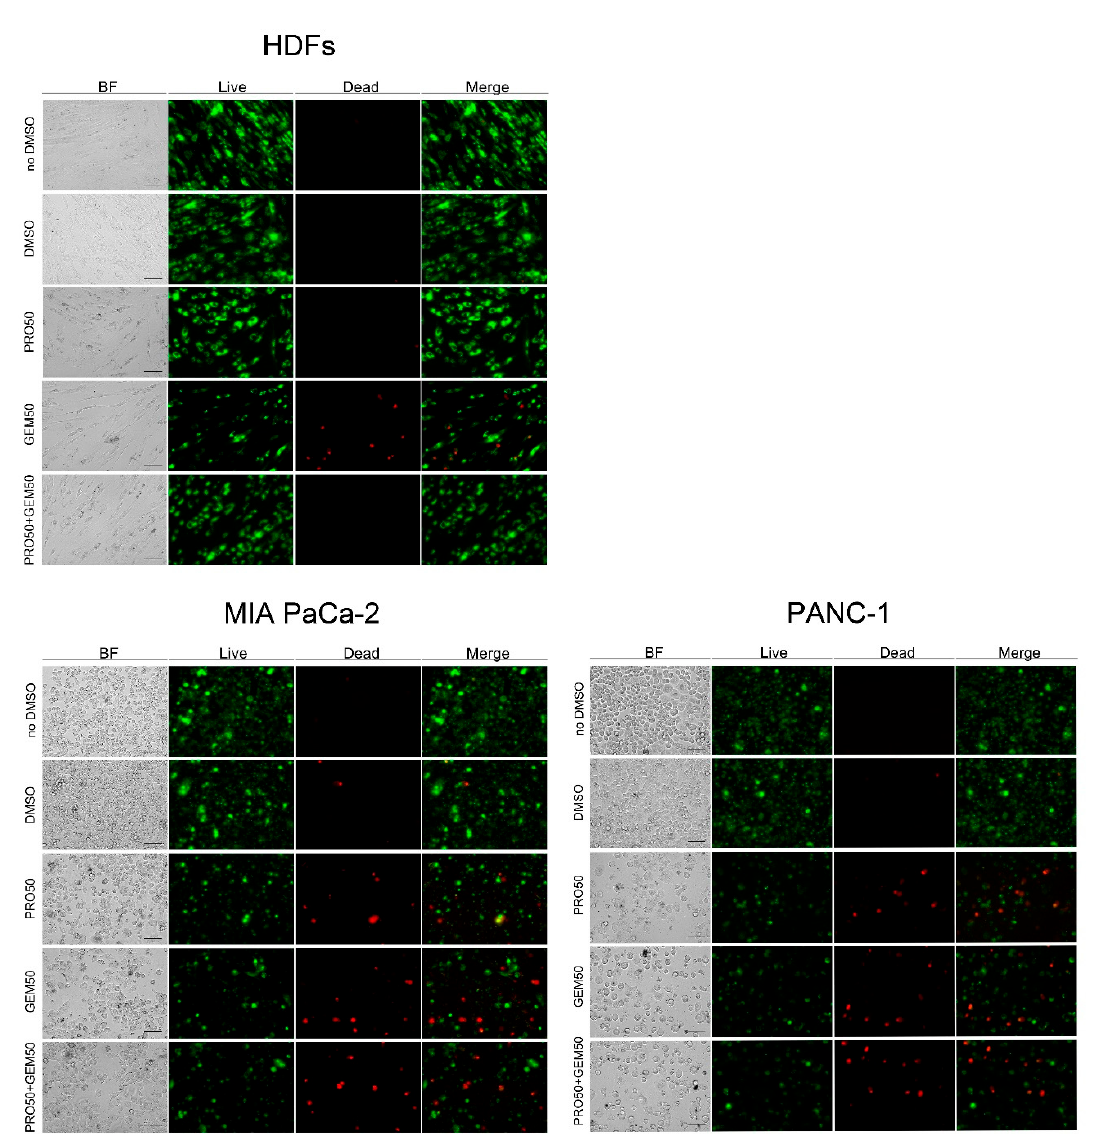
Figure 3. Fluorescence micrographs of LIVE/DEAD-stained HDFs, MIA PaCa-2, and PANC-1 cells. Cells were treated in the presence of 50 μ M PRO, 50 μ M GEM or 50 μ M PRO + 50 μ M GEM for 48 h or in the presence or absence of DMSO as vehicle (controls). Figures are representative images obtained with fluorescence microscopy, as reported in Materials and Methods. Green-labeled DiOC18(3)-positive cells correspond to live cells, red-labeled propidium iodide-positive cells correspond to dead cells. BF = brightfield. Scale bar = 100 μ m, represented in BF images, is valid for all images.